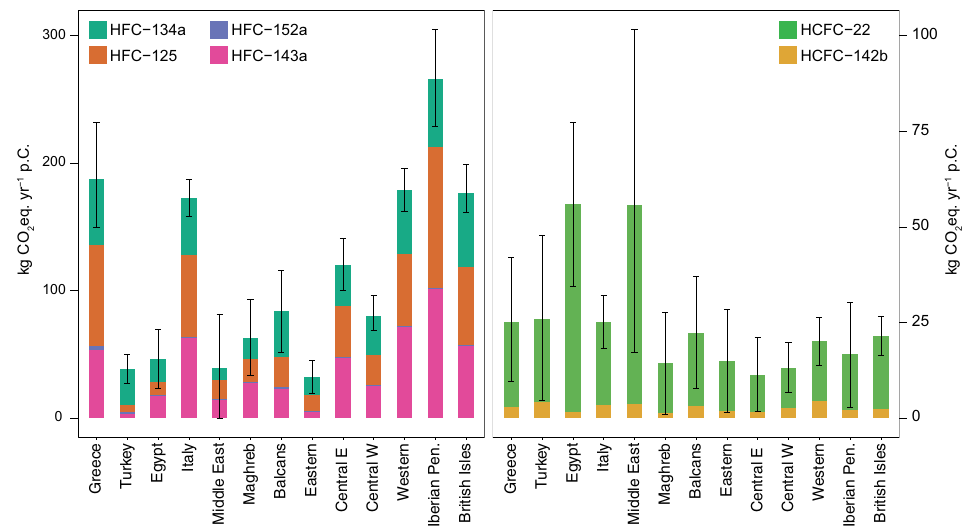
Figure 8. Annual per-capita (p.C.) emissions in CO 2 equivalents, derived from the BASE inversion and all sensitivity inversions (best estimate). The results have been computed using the 100-yr global warming potential (GWP 100 ) values of Harris et al. (2014). The bars show the average mean of all inversions, whereas the error bars show our uncertainty estimate including analytical and structural uncertainty.